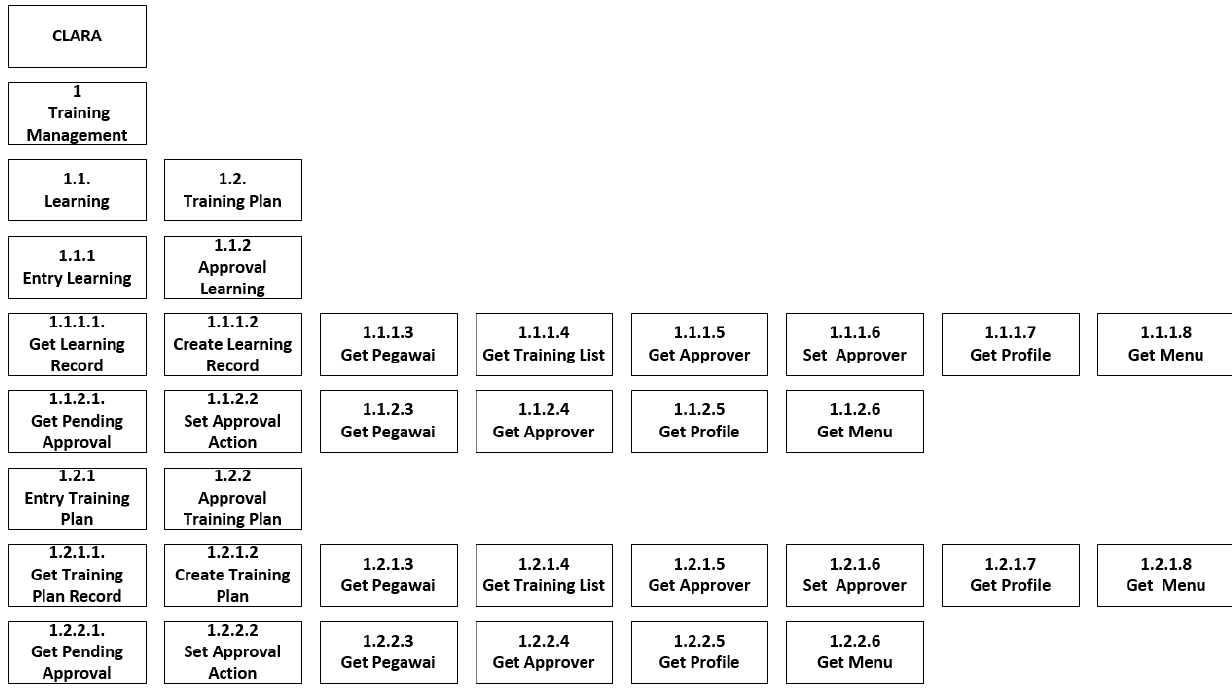
Figure 6. Domain